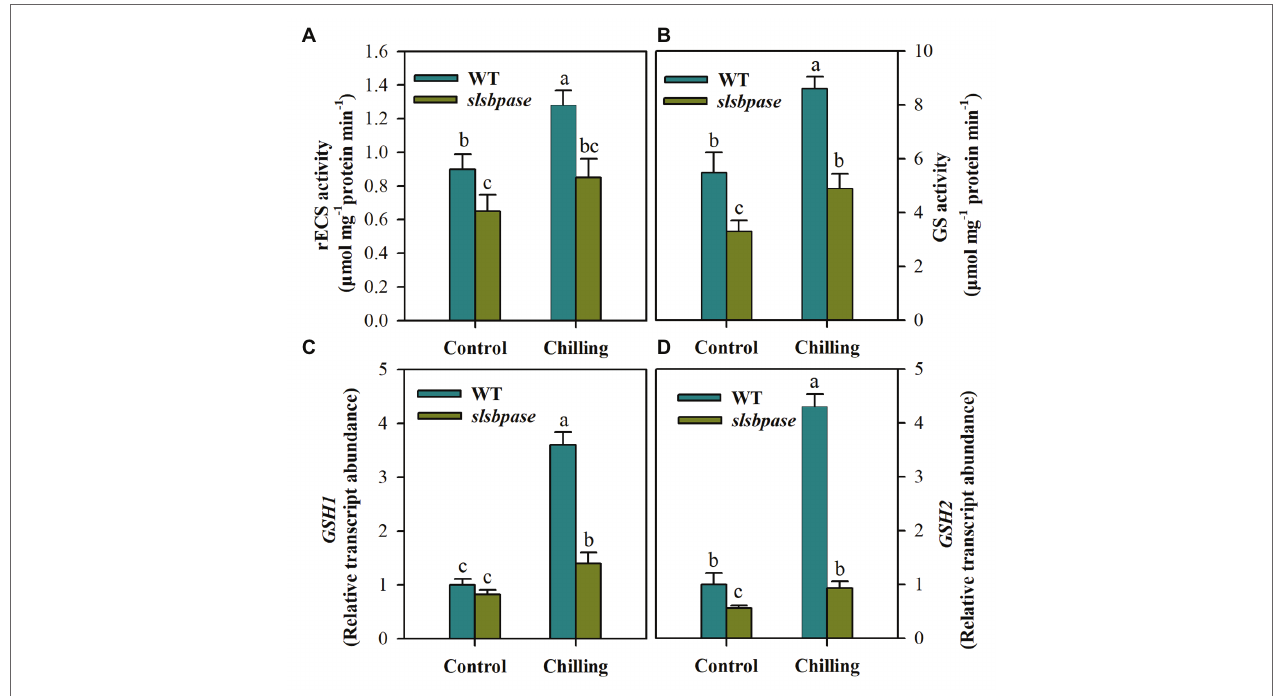
FIGURE 6 | Activities of gamma-glutamylcysteine synthetase ( γ -ECS; A ) and glutathione synthetase (GS; B ) in the pathway of GSH biosynthesis and relative transcript abundance of GSH1 (C) and GSH2 (D) . At the fourth-leaf stage, slsbpase mutants and wild-type plants were subjected to a 24 h chilling stress. Following that, leaves from different groups were sampled for the determination of enzyme activities and transcript abundance. The expression level in wild-type leaves under control conditions was set to 1, and the relative expression level in the rest of samples was calculated accordingly. The results are mean values ± SDs from three independent experiments, and different letters on top of each column represent significantly different values at p < 0.05 among